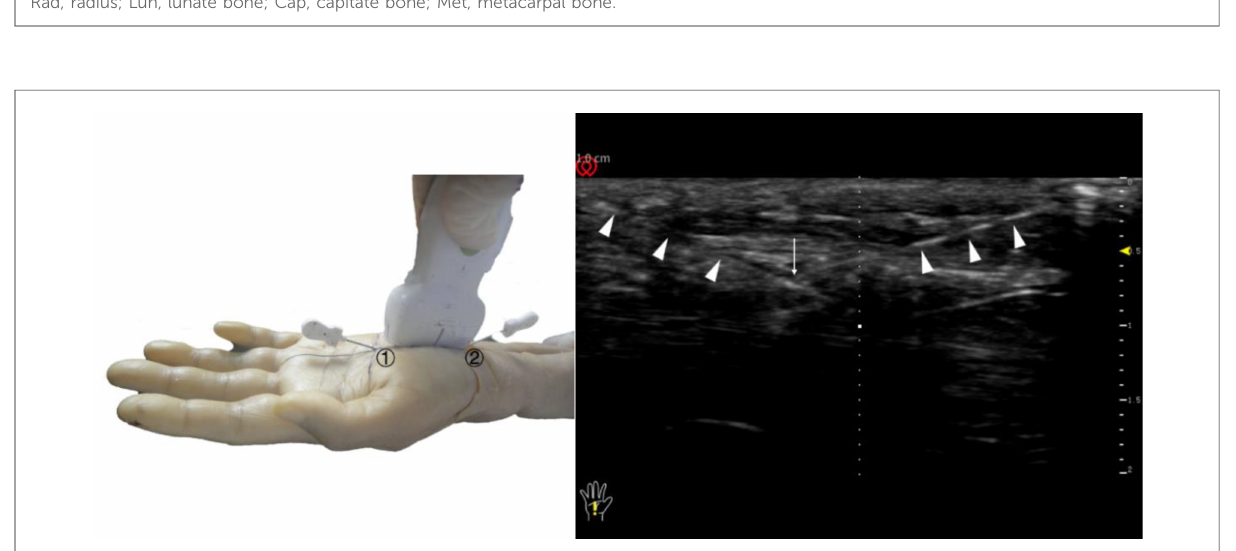
FIGURE 7 Ultrasound guided needle knife release technique completed (left) and ultrasound long axis display (right). The triangle refers to the needle knife position. The long arrow points to the intersection of the needle points of the needle knife. ① , needle entry point 1; ② , needle entry point